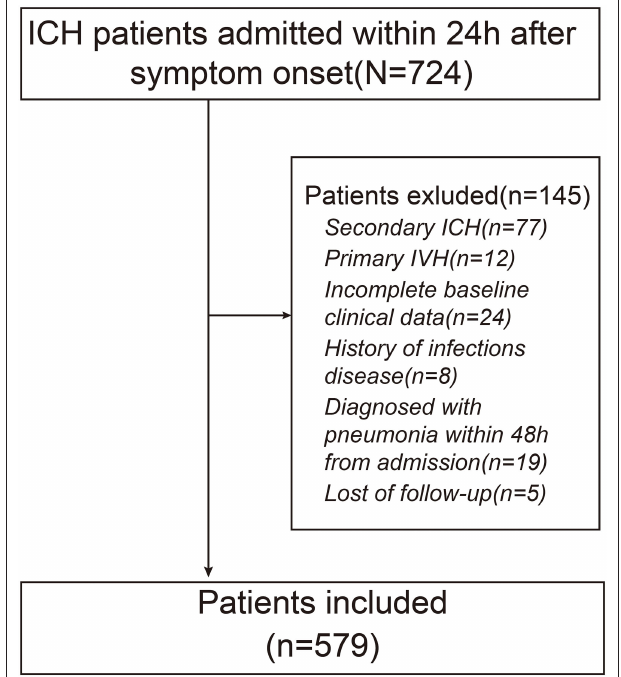
FIGURE 1 | Flowchart of study